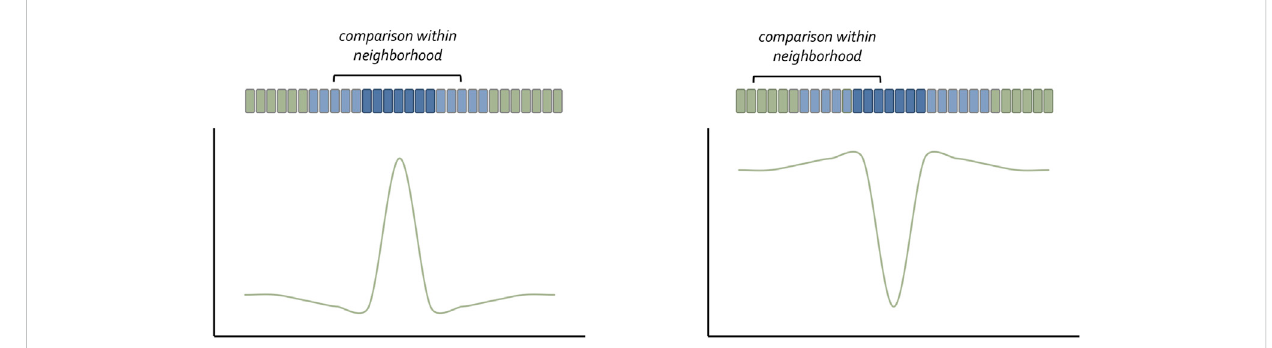
FIGURE 3 The neighborhood watch model for understanding how cells understand their position within a concentration gradient. Claudio Stern has recently proposed that a cell cannot interpret the absolute value of the morphogen it captures. Instead, it compares itself with its neighbors to make a relative calculation as to the amount of morphogen it has received. The schematic was adapted from Lee et al.,